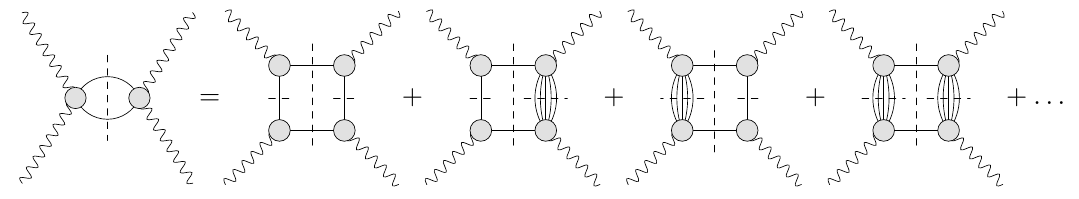
Figure 5. Two-pion contributions to HLbL. Further crossed diagrams are not shown